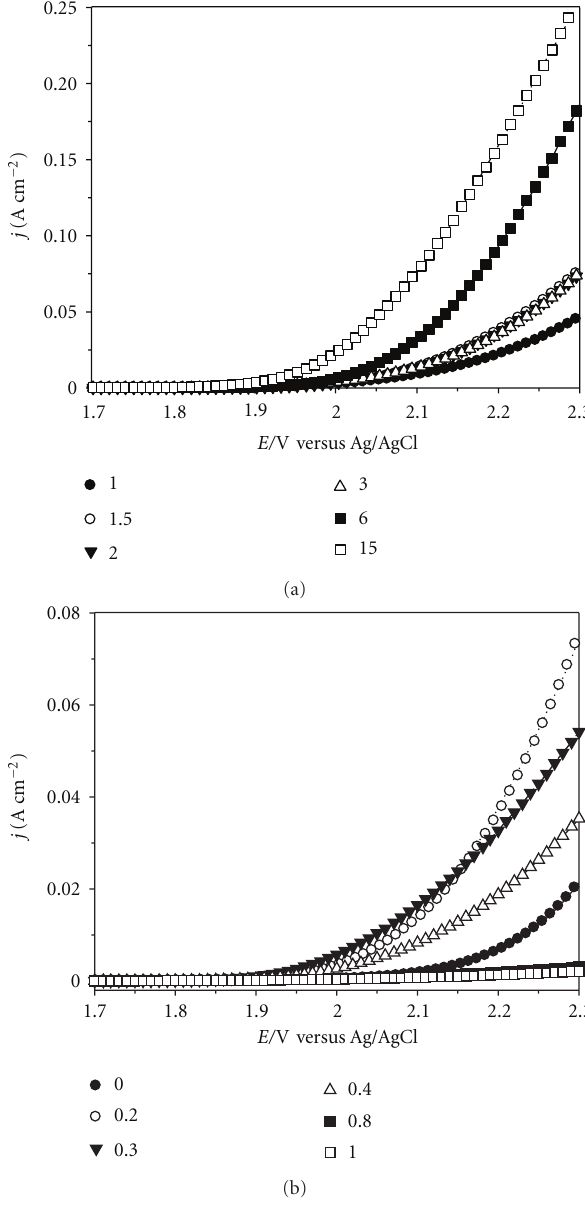
Figure 8: Linear sweep voltammograms of Ti / SnO 2 -Sb( x %)- Ni(0.2%) electrodes at di ff erent Sb contents (a) and Ti / SnO 2 - Sb(2%)-Ni( x %) electrodes at di ff erent Ni contents (b) in o.1 M H 2 SO 4 solution at 25 ± 1 ◦ C. Scan rate: 1mVS − 1 . The values in parentheses are atomic ratios with respect to